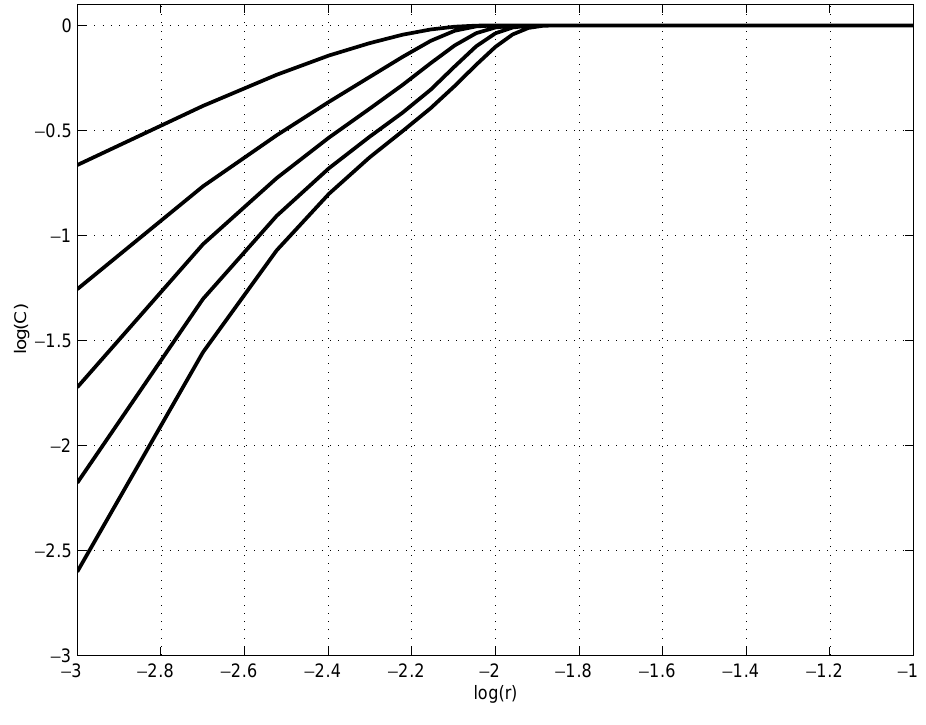
Fig. 4. Estimation of the embedding or attractor dimension ( d ).